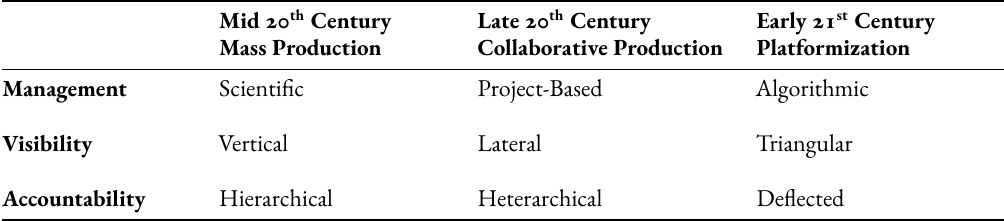
Table 1: Historical Patterns of Management, Visibility, and